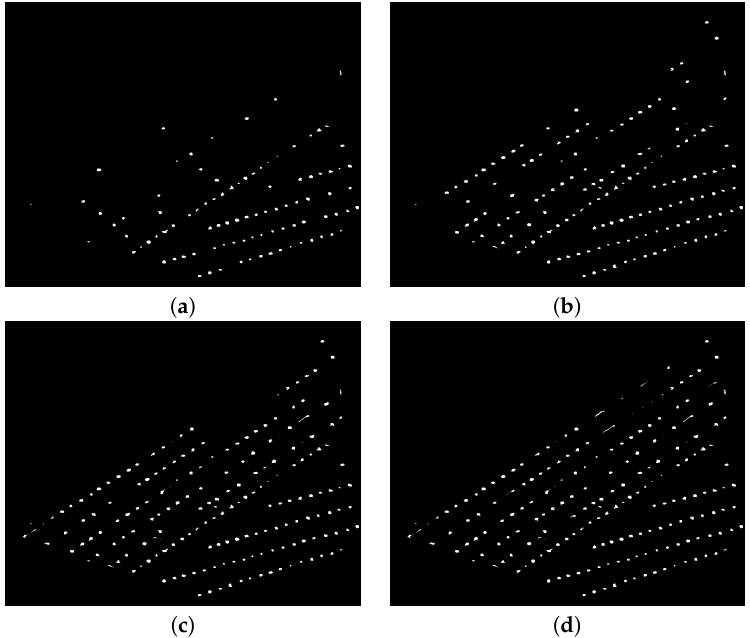
Figure 12. Images representing some iterations of the counting algorithm for a region in Figure 10: ( a – d ) show the detected plants after the iterations 1, 5, 8, and 13,